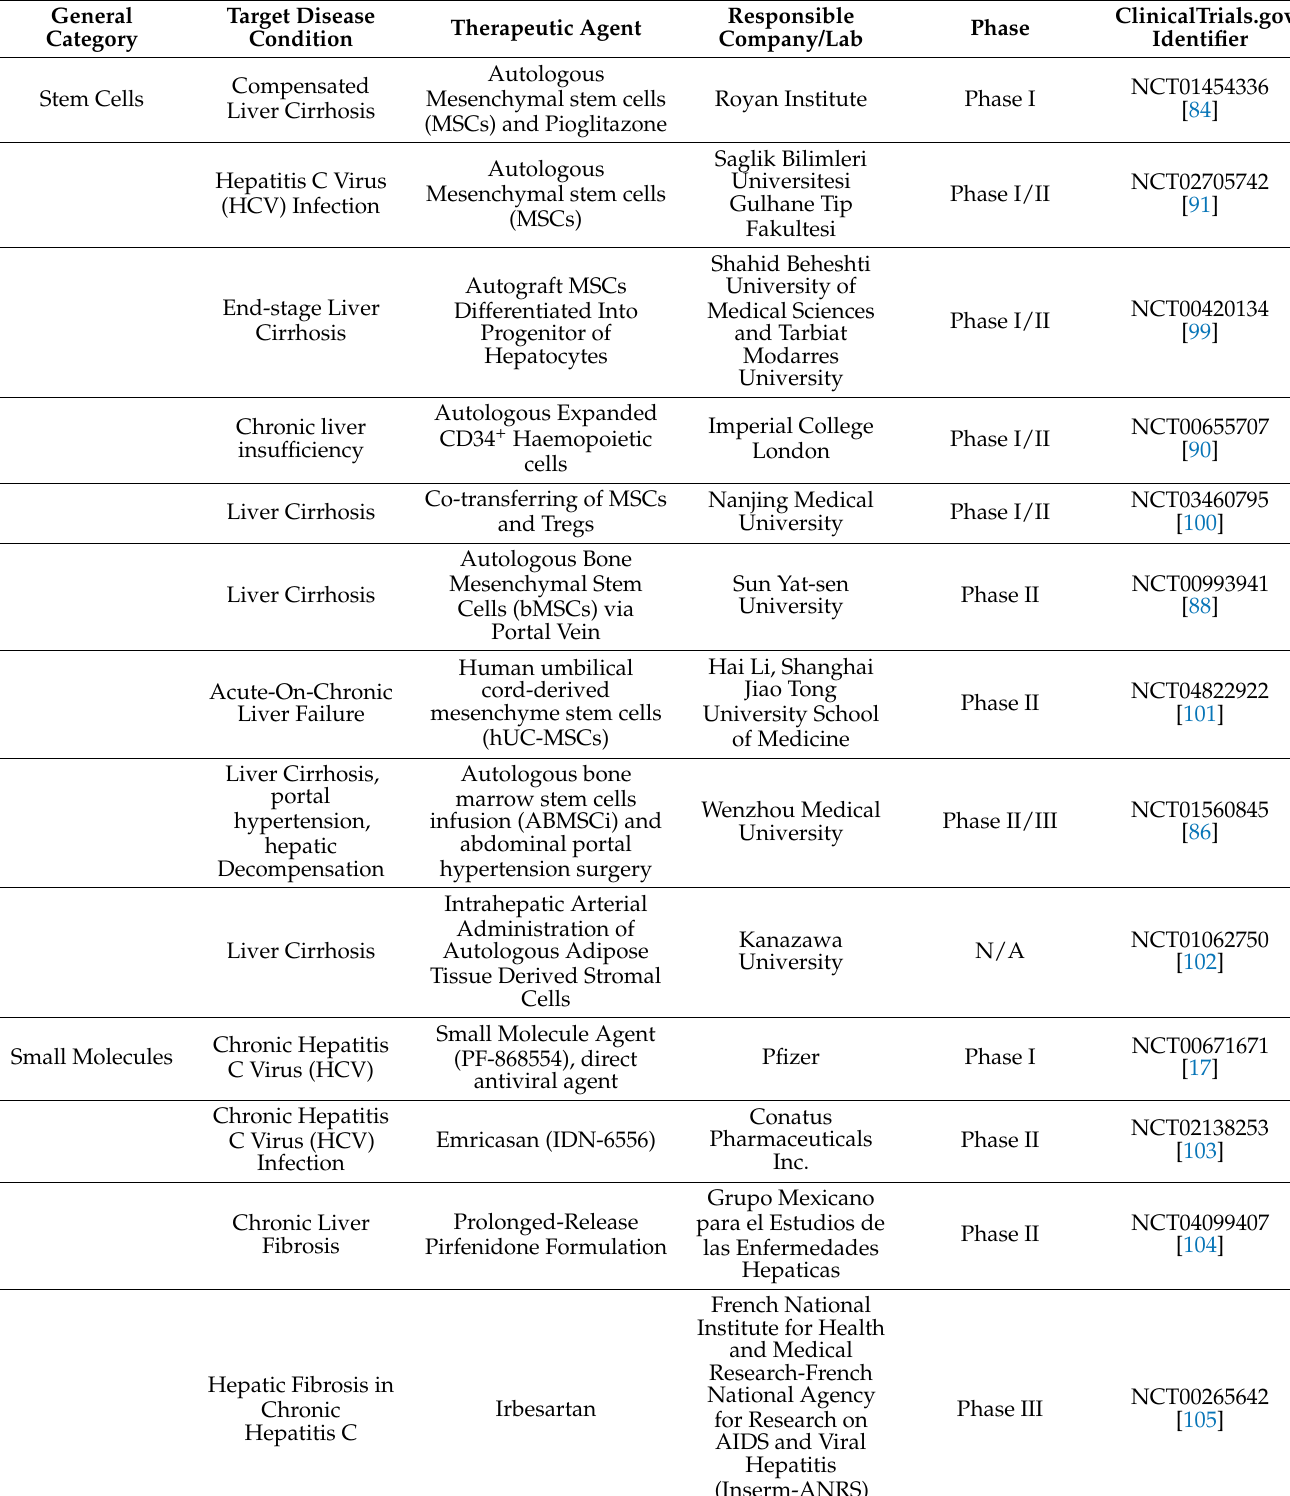
Table 1. Selected clinical treatments, therapies, and diagnostic tools for liver fibrosis. General